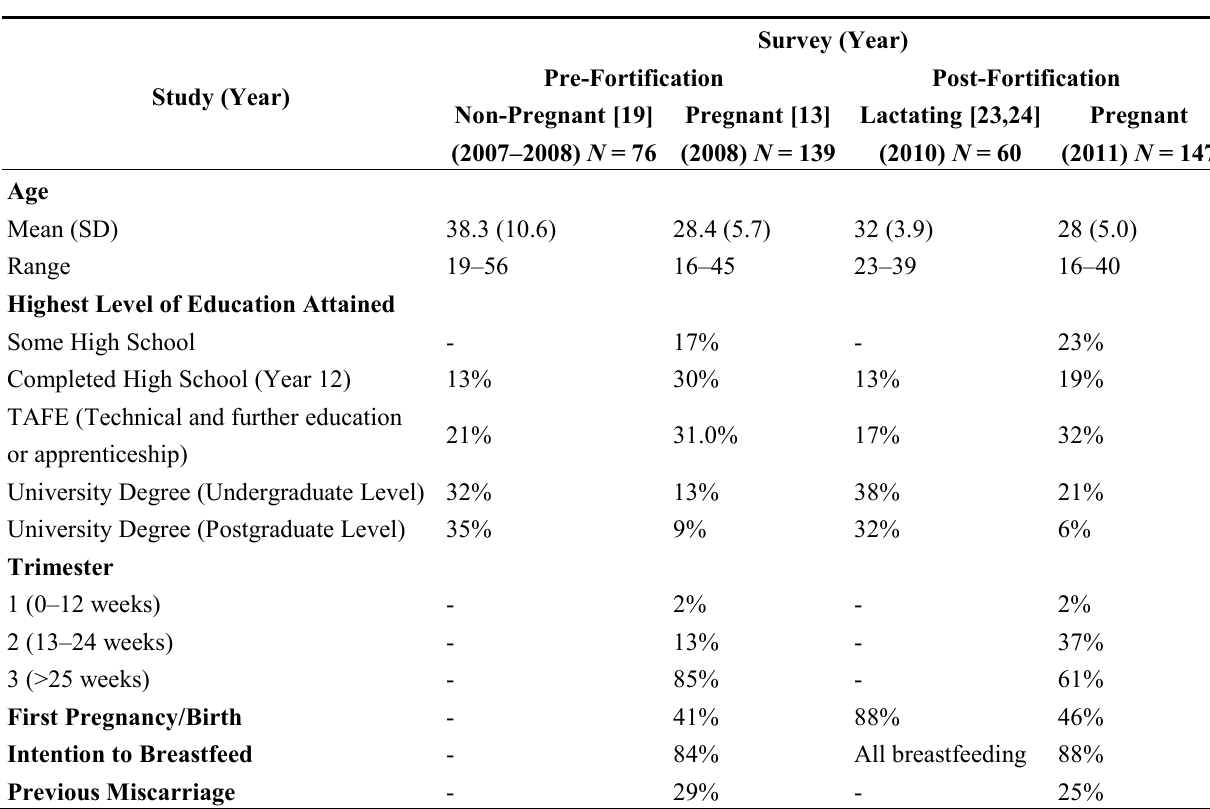
Table 1. Sample characteristics including age, pregnancy trimester, previous miscarriage and education